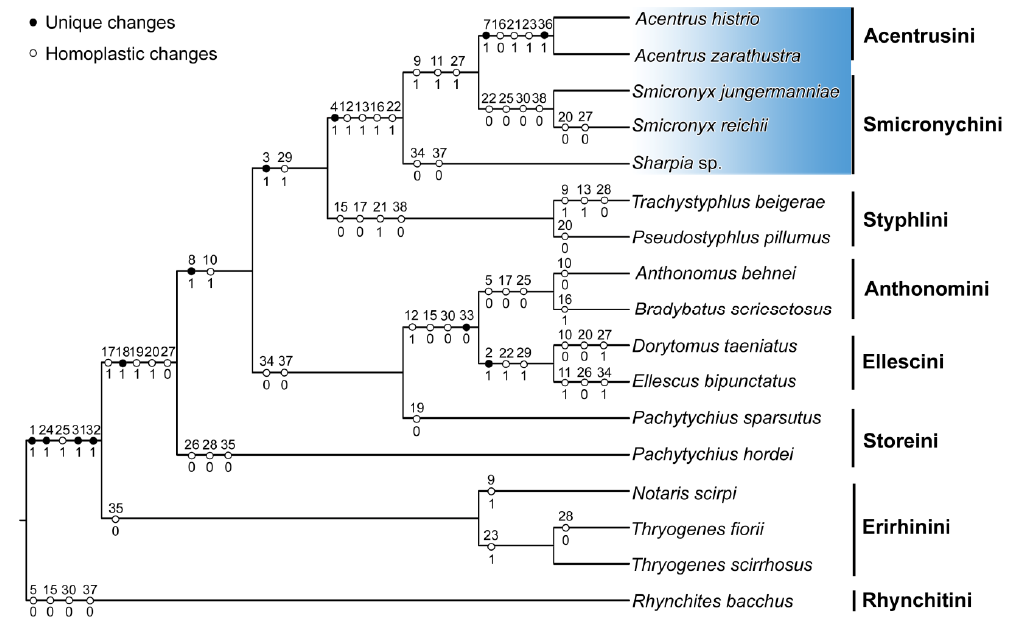
Figure 5. Evolution of character states in seven tribes of the family Curculionidae and one outgroup species ( Rhynchites bacchus ). Changes in character states were mapped on the most parsimonious tree shown in Figure 4, using the parsimony reconstruction method implemented in Mesquite. Black dots indicate unique character changes, while white dots indicate homoplastic changes.